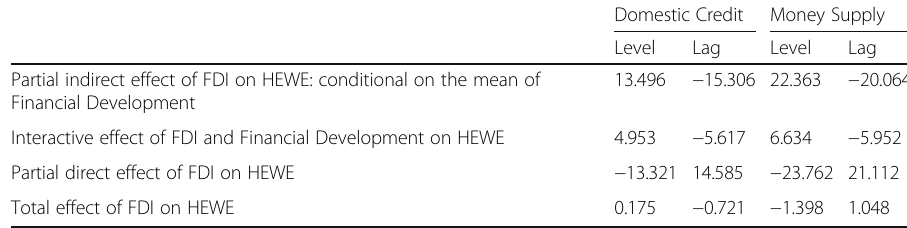
Table 4 Effect of FDI on HEWE, conditional on